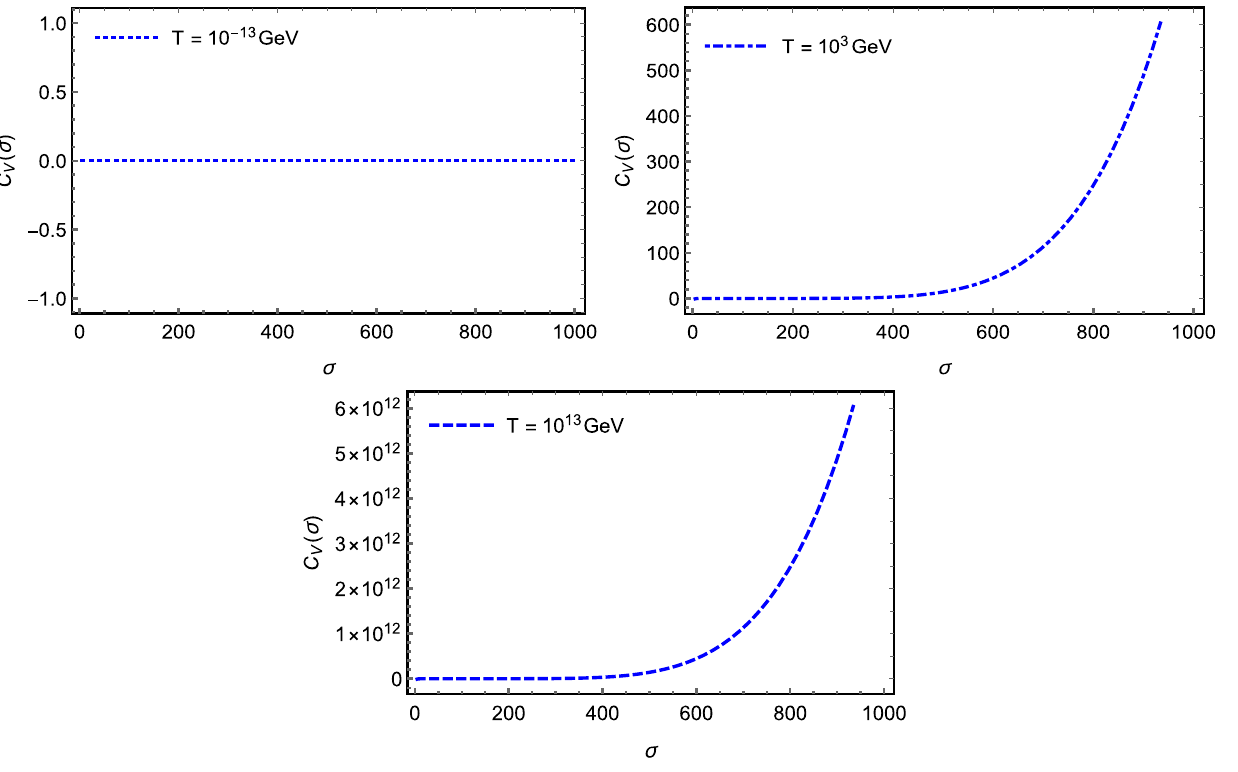
Fig. 7 The plots show the modification to the heat capacity C V (σ) as a function of σ (its unit is GeV − 1 ) considering the temperatures of cosmic microwave background (top left), electroweak scenario (top right), and the early inflationary universe